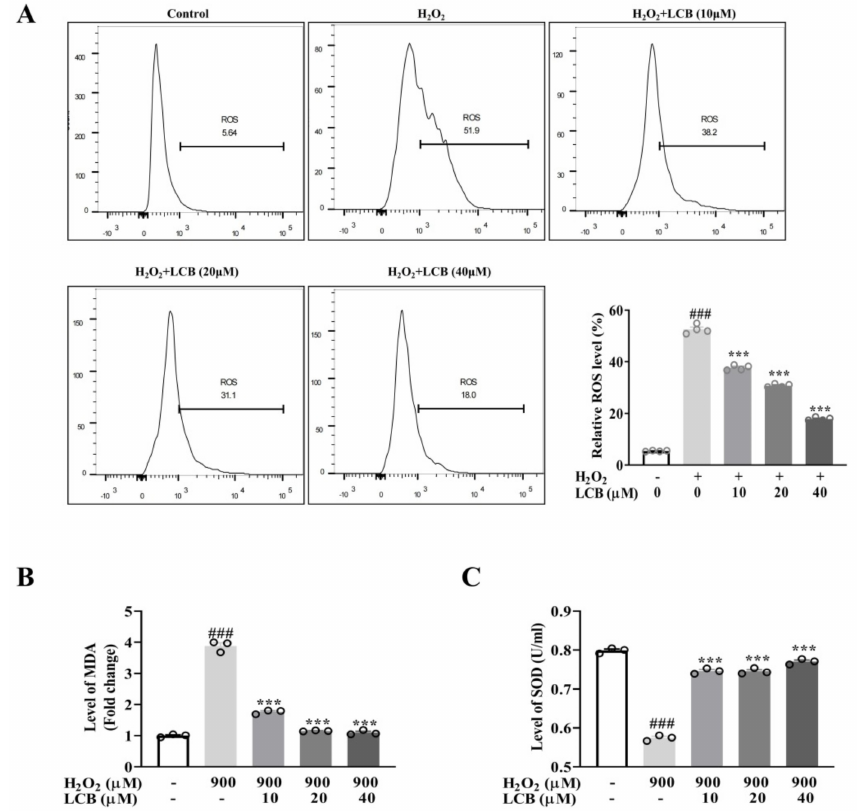
Figure 3. Effect of LCB on H 2 O 2 -induced oxidative stress in PC-12 cells. ( A ) PC-12 cells were pretreated with 25 µ M of LCB for 16 h before exposure to 900 µ M H 2 O 2 for 6 h. The mean fluorescence intensity of intracellular ROS was quantified using flow cytometry. ### p < 0.001, H 2 O 2 group vs. control; *** p < 0.001, H 2 O 2 + LCB group vs. H 2 O 2 group. ( B , C ) PC-12 cells were pretreated with 10, 20, or 40 µ M of LCB for 16 h before exposure to 900 µ M H 2 O 2 for 6 h. MDA and SOD levels were conducted in H 2 O 2 -induced PC-12 cells (with or without the treatment of LCB) as the indicated